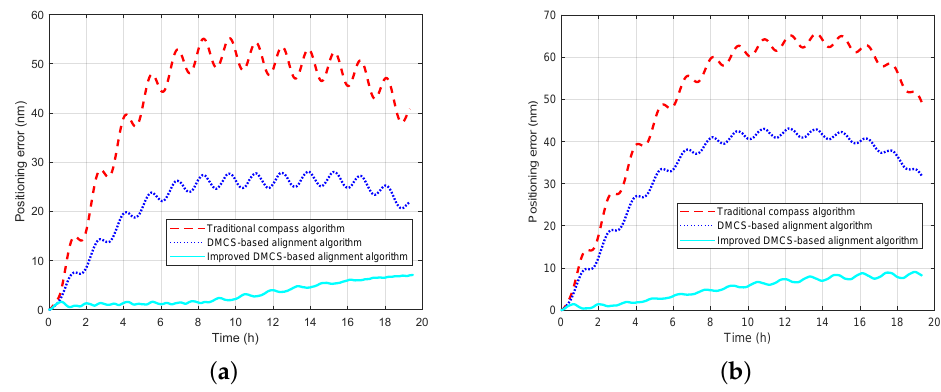
Figure 17. Positioning error curve when the initial alignment lasts 25 min. The red dashed line denotes the positioning error curve by utilizing the traditional compass algorithm under the static base; the blue dotted line denotes the positioning error by utilizing the DMCS alignment algorithm under the single-axis rotating base; the light blue solid line denotes the positioning error by utilizing the improved DMCS-based alignment algorithm under the rotating base. ( a ) Positioning error when the initial heading error is 125 ◦ . ( b ) Positioning error when the initial heading error is − 170 ◦ . Table 4. Comparison of positioning